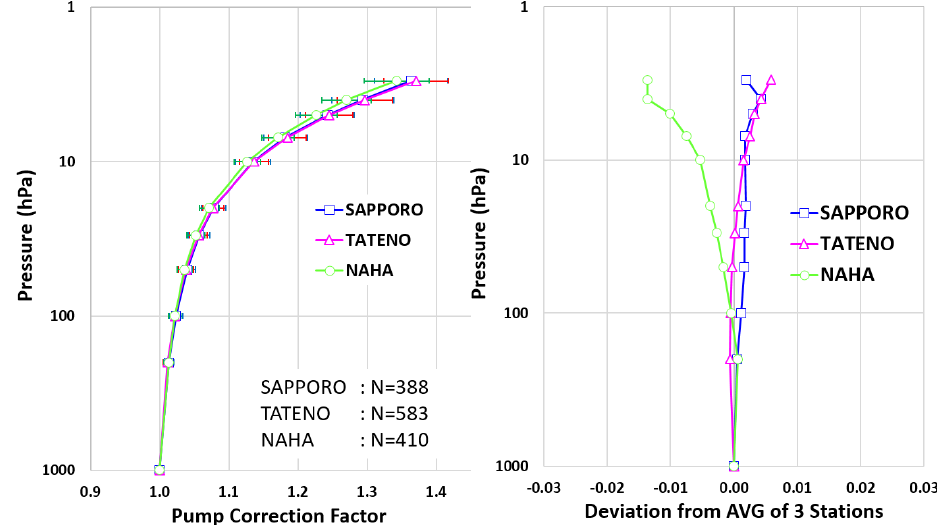
Figure 11. Pump-efficiency measurement for Sapporo and Naha from 2009 to 2018 and Tateno from 2009 to 2022. The error bars in the left-hand-side figure represent 1 σ standard deviation. All the sites show close